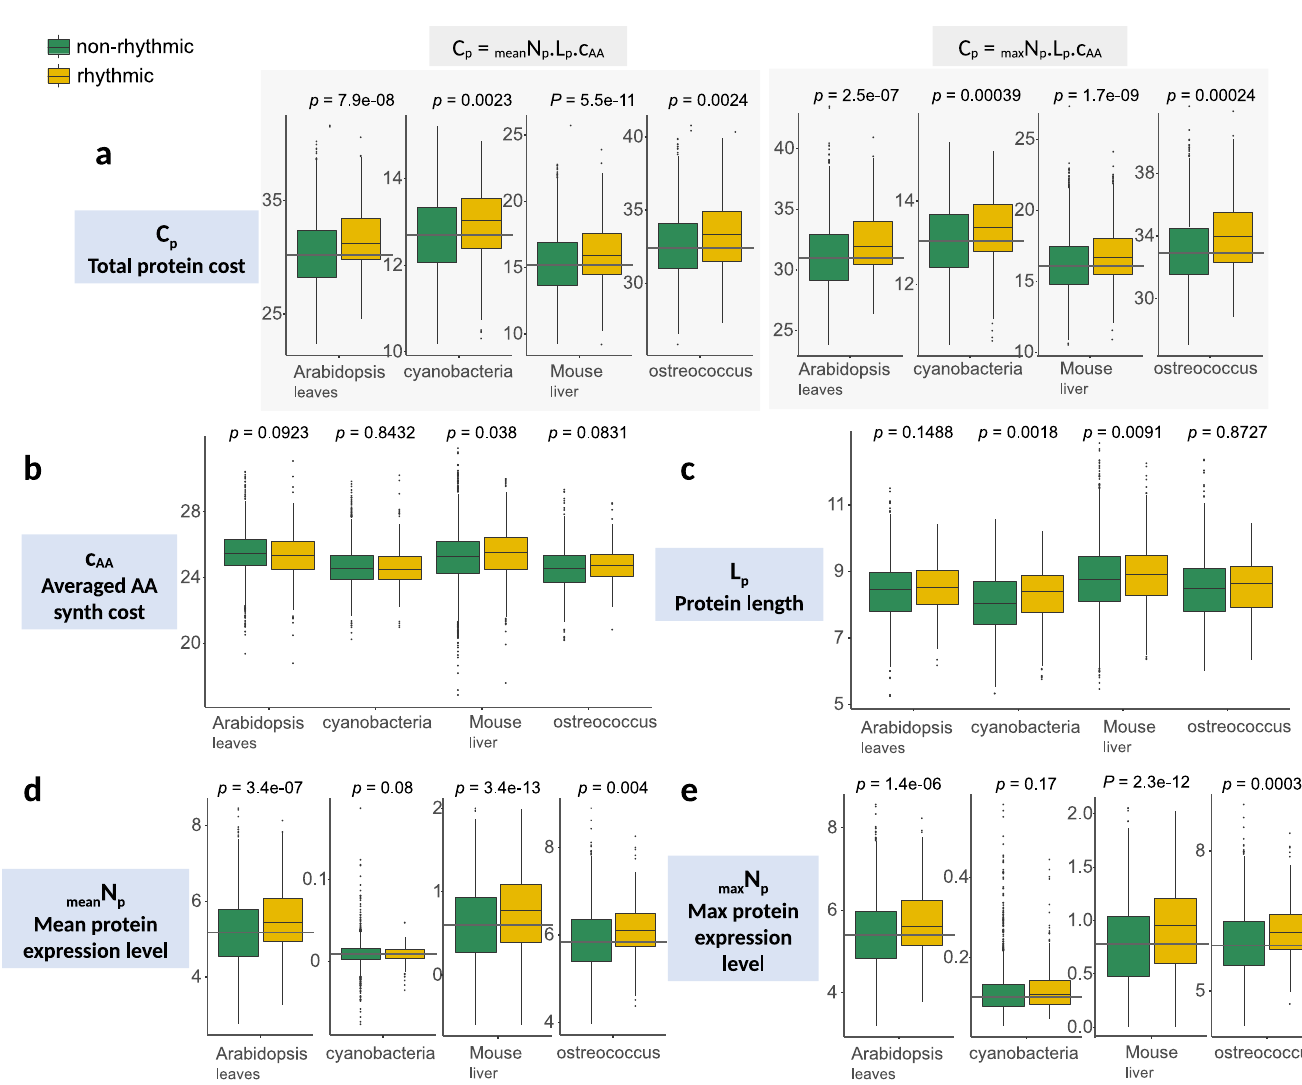
Fig 2. Among the factors of expression costs, expression level is the main factor explaining the higher cost observed in rhythmic proteins. a) The total cost of rhythmic proteins is higher than those of other proteins. b) With the exception of mouse liver, rhythmic proteins do not contain more expensive amino-acids than other proteins. c) Rhythmic proteins can be longer in some species. d-e) Mean or maximum expression level calculated from time-series datasets: rhythmic proteins are highly expressed proteins. Boxplots are log scaled except for the averaged AA synthesis cost. The first 15% of proteins from p -values ranking (from the most rhythmic to the most un-rhythmic genes) obtained from the rhythm detection algorithms were classified as